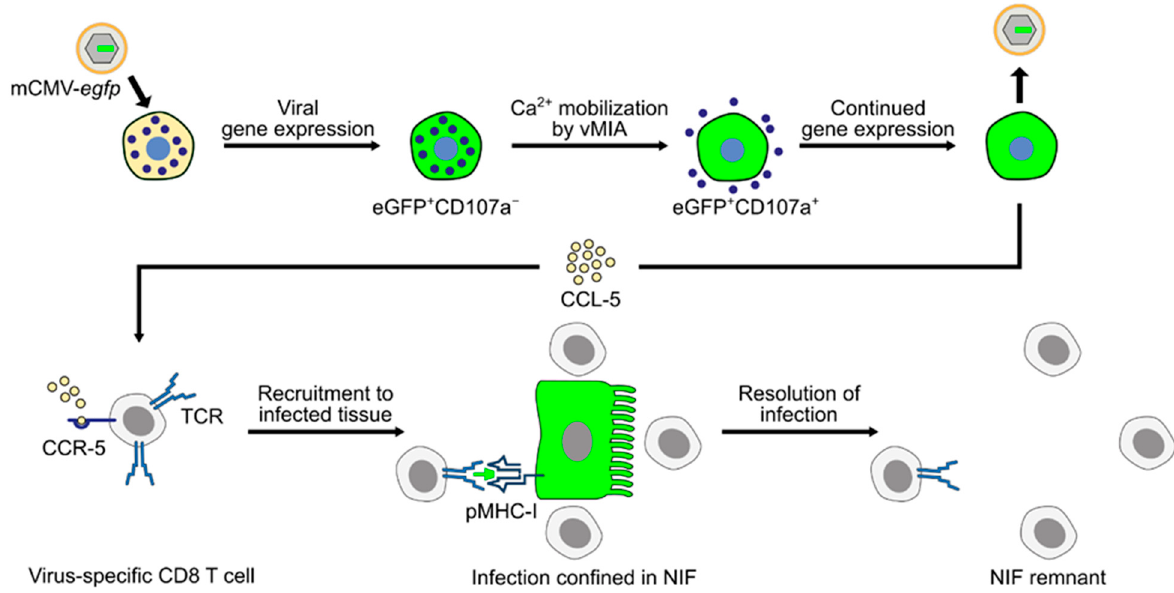
Figure 5. Graphical abstract summarizing the current knowledge regarding the role of MC in controlling CMV infection in the mouse model of CMV disease. Reporter protein eGFP (green color) is used to indicate infection. (TCR) T-cell receptor; (pMHC-I) MHC class-I molecule presenting viral peptide to cognate CD8 T cells; (NIF) nodular inflammatory focus; and (vMIA) viral mitochondria- localized inhibitor of apoptosis.